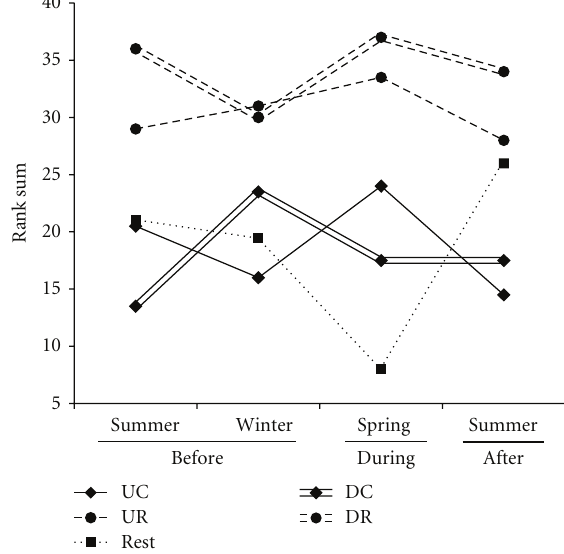
Figure 1: Cacapon River, WVa, USA restoration, control, and reference sampling reach rank sum scores for macroinvertebrate modified index of biotic integrity (IBI) across all sampling seasons: before (two samples, 2009-2010), during (2010), and after (2010) restoration. Higher scores indicate healthier communities based on the metrics measured. Upstream control (impaired reach, but not receiving restoration) denoted “UC”, downstream control denoted “DC”, upstream reference (unimpaired, natural reach) denoted “UR”, and downstream reference denoted “DR”. The restoration reach is denoted as